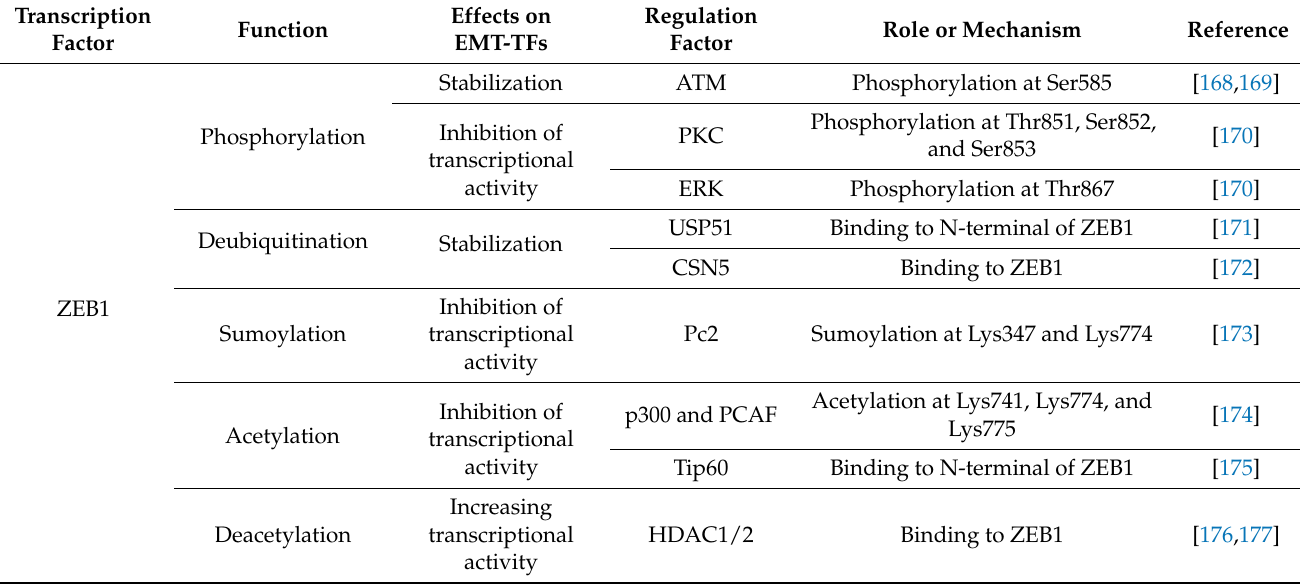
Table 3. Regulation of the ZEB family by